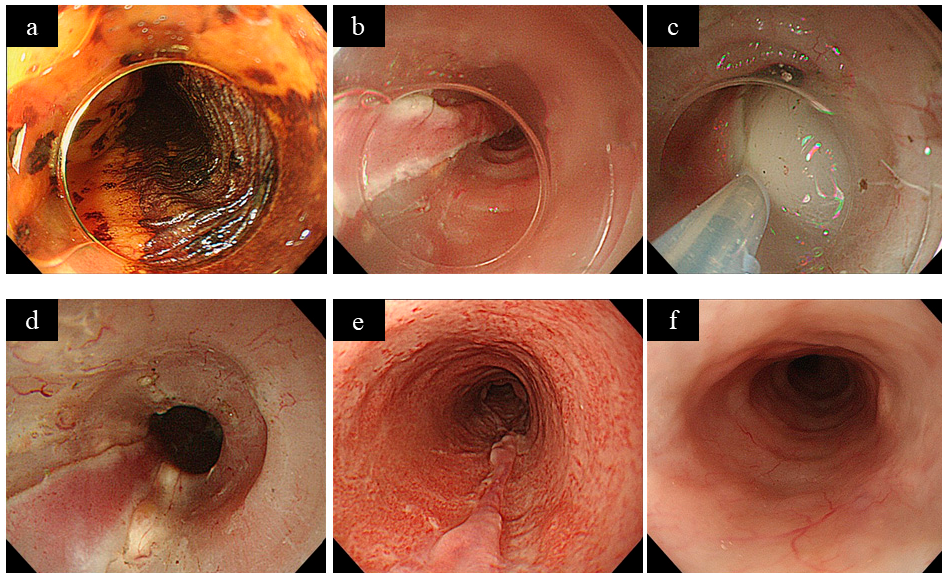
Figure 1. A case of steroid injection therapy. ( a ) Squamous cell carcinoma of the middle thoracic esophagus with a 3/4 circumference, 3 cm long in the long axis. ( b ) Endoscopic submucosal dissection (ESD) was performed with a mucosal defect of 7 cm in the longitudinal diameter of the 9/10th circumference. ( c ) Immediately after ESD, triamcinolone (100 mg) was administered locally to the mucosal defect. ( d ) After the injection, the injected area became white in the submucosa. ( e ) After two weeks of ESD. The mucosal defect was epithelialized. ( f ) One year after ESD. No stricture was seen.